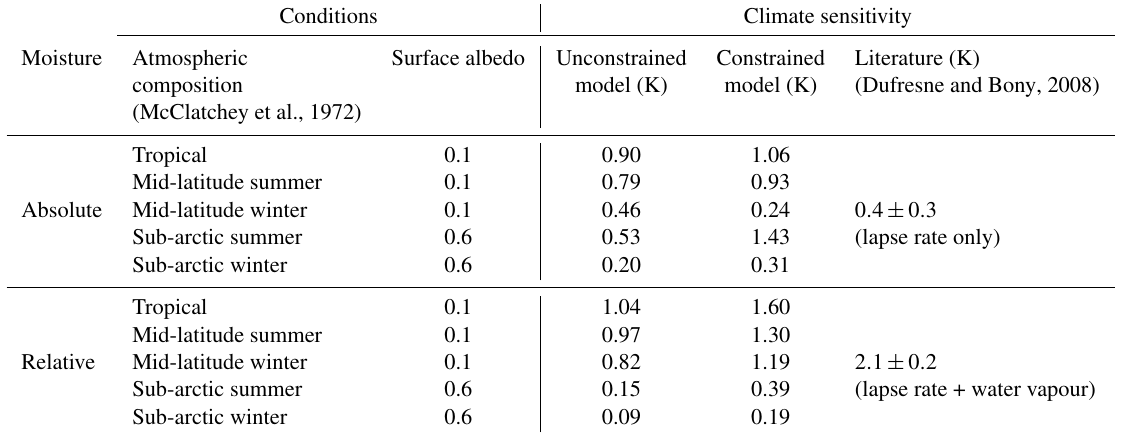
Table 1. Climate sensitivity (warming, in K, of the surface due to a doubling of CO 2 concentration) of the constrained model with e = C p T + gz + Lq s , unconstrained model of Herbert et al. (2013), and literature (Dufresne and Bony, 2008). We give the values for different atmospheric compositions and for fixed absolute or relative water vapour